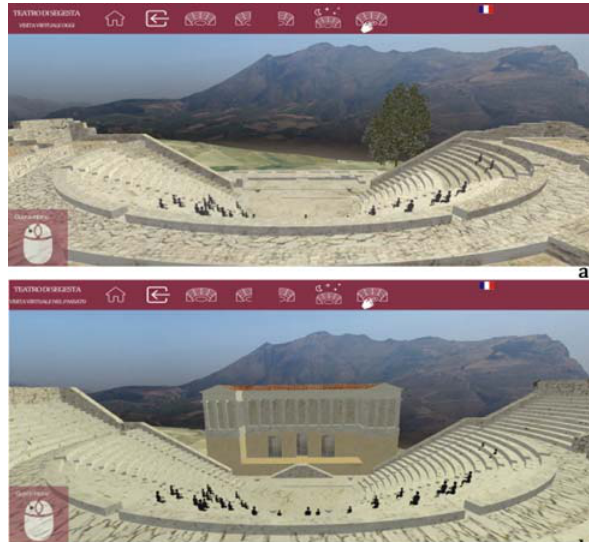
Figure 14. Interactive free navigation inside the Segesta Theatre today (a) and in the past